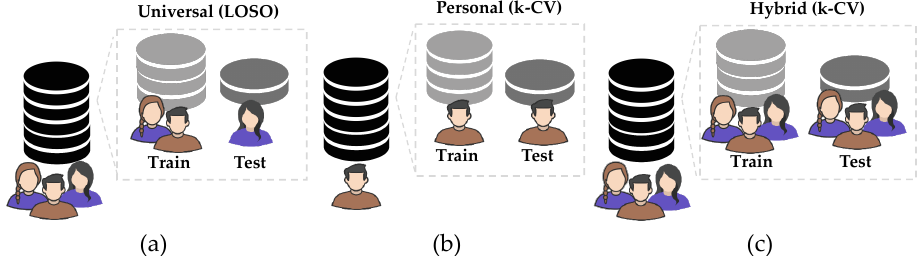
Figure 2. Visualization of each procedure used to build the model types for HAR systems. To build universal models, the LOSO procedure ( a ) separates train and test by subjects. For personalized models ( b ), the k -CV is used with samples of only one subject. Finally, for hybrid models ( c ), the k -CV is also used, but in this case, for a group of subjects, data are split by samples into the training and test